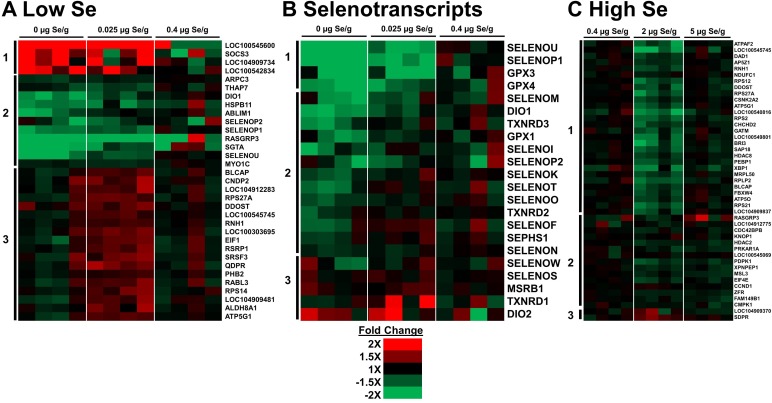
Hierarchical cluster analysis of significant DE transcripts (q < 0.1 in one or more treatments).Values (n = 4/treatment) are fold changes relative to the mean of Se-adequate (0.4 μg Se/g) poults. (A) Analysis of low-Se treatments in study 1 (n = 33); (B) Analysis of remapped selenotranscripts of low-Se treatments in study 1 (n = 22); (C) Analysis of high Se treatments in study 2 (n = 45). Vertical bars show major clusters.